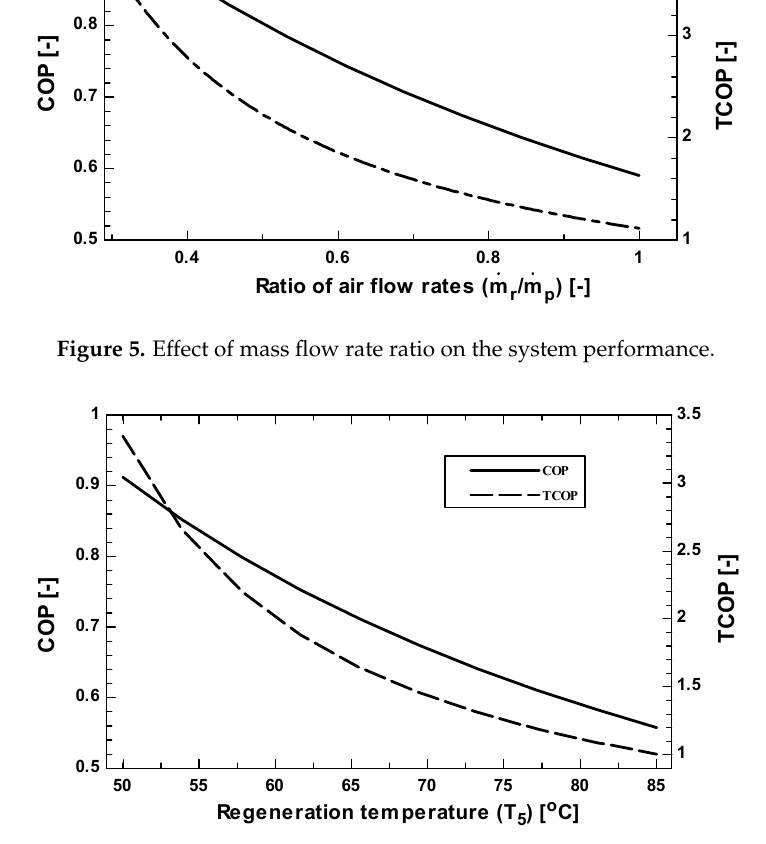
Figure 5. Effect of mass flow rate ratio on the system performance.